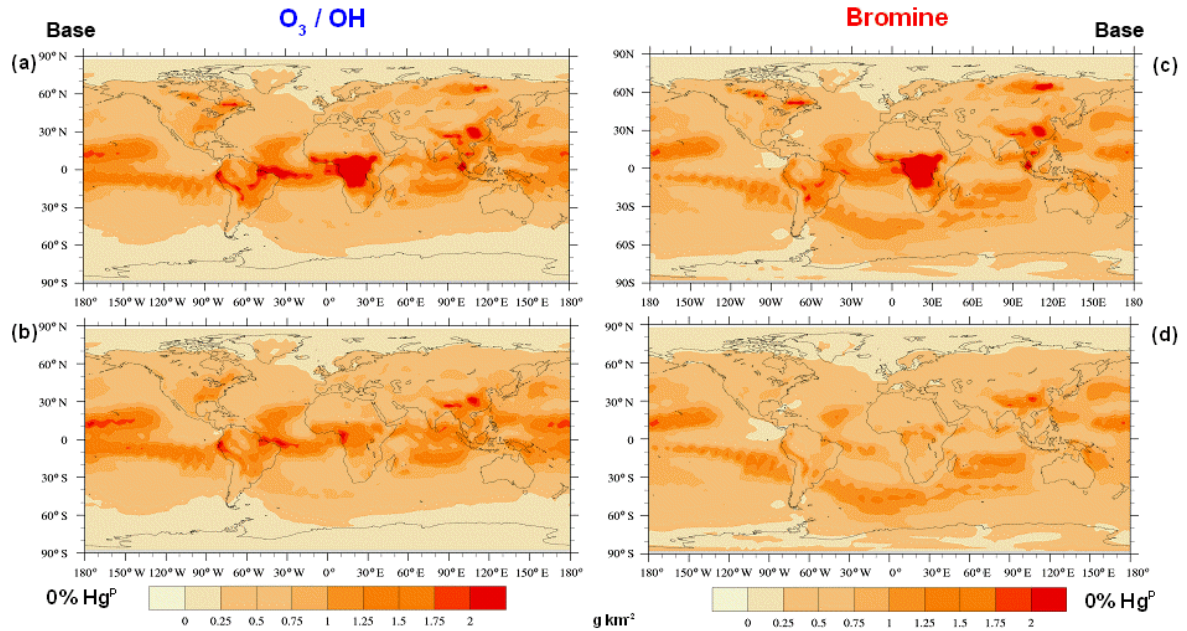
Figure 6. Geographical distribution of the Hg total deposition from model runs including only BB emission sources and assuming two